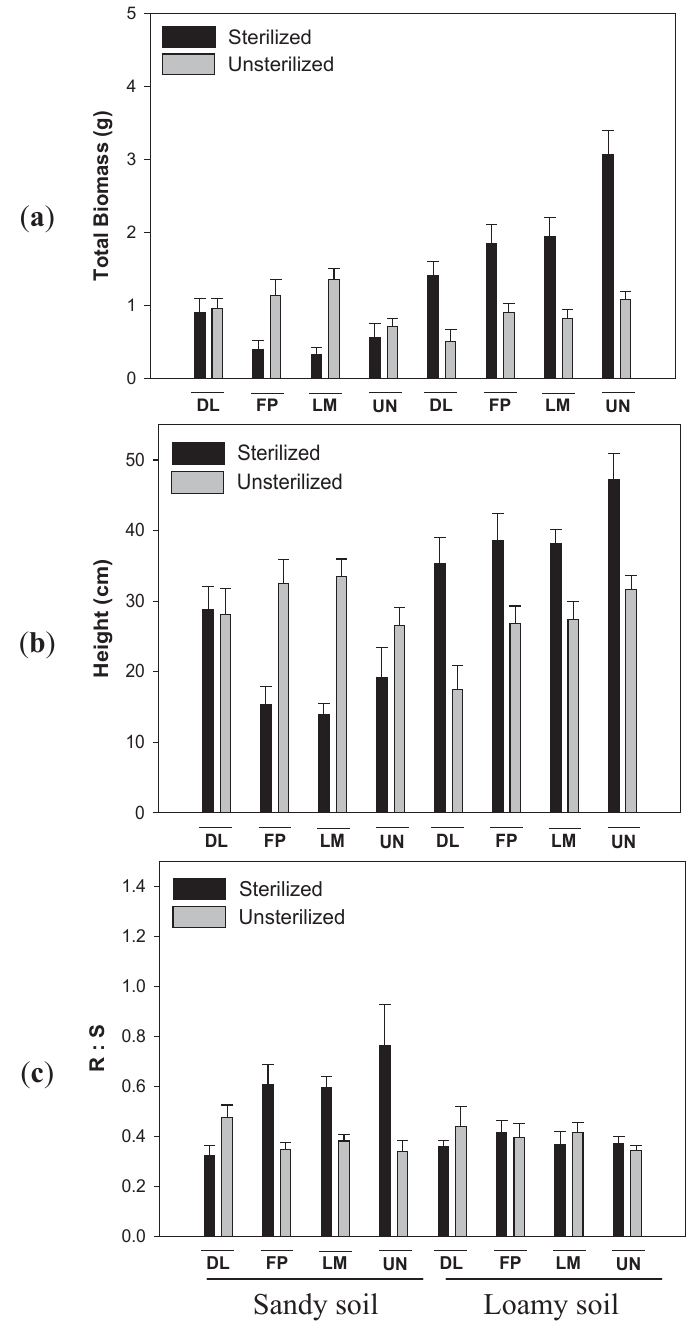
Figure 1: Mean (+1 SE) ( a ) total dry biomass; ( b ) end of season height; and ( c ) root/shoot ratio of Lonicera maackii in response to soil sterilization and soil conditioning by three different species in two soil types. Conditioning treatments: DL = Diervilla lonicera